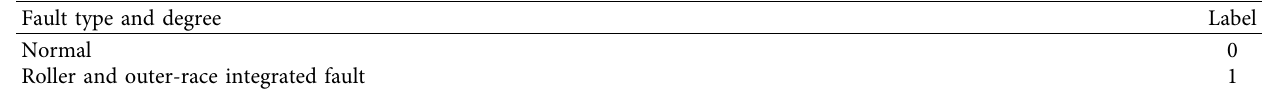
Table 13: Fault classification label table.